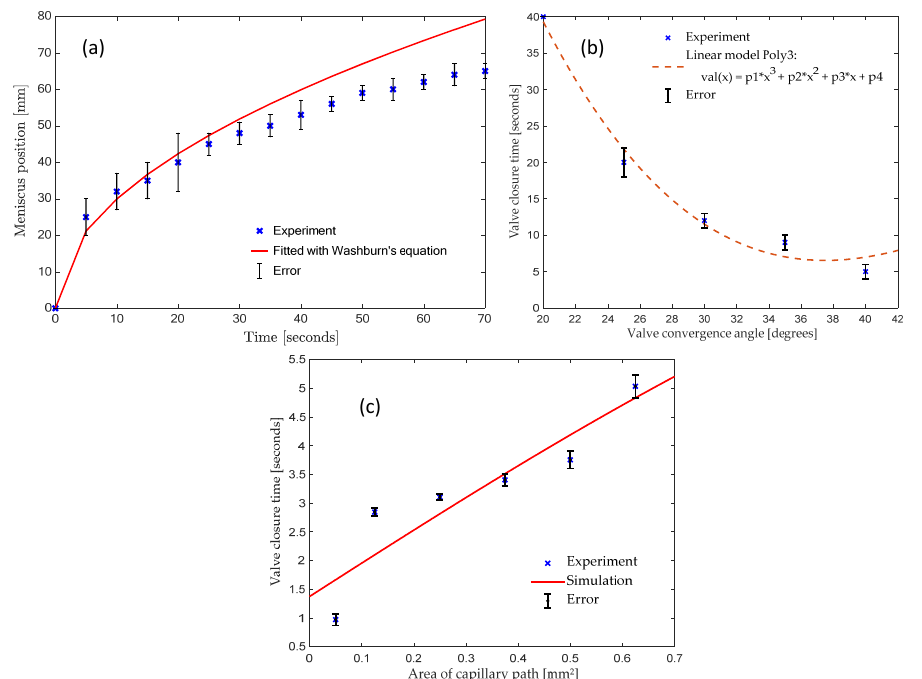
Figure 8. ( a ) Plot of the time of vs. advancement of the molten ferrowax meniscus in the fluidic channel under capillary action. The experimental values are indicated by blue cross marks (where the error bars represent one standard deviation). The red line indicates the trend corresponding to Washburn’s Equation (Equation (9), with W = 9.47). The simulation predictions of the molten wax location (Washburn’s Equation) are within 18.75% of the error margin with respect to experimental results. ( b ) Plot depicting the relationship between the valve convergence angle (see Figure 3b for definition) and the time it takes for the molten wax to reach the fluidic channel. The error bars represent one standard deviation. Dotted line is a fitted curve to the blue crosses. ( c ) Relationship between the valving channel cross-section and the response time. The red line shows the simulated curve and blue crosses represent experimental measurements done using the Hamilton syringe setup where we use a Hamilton syringe to input the wax.